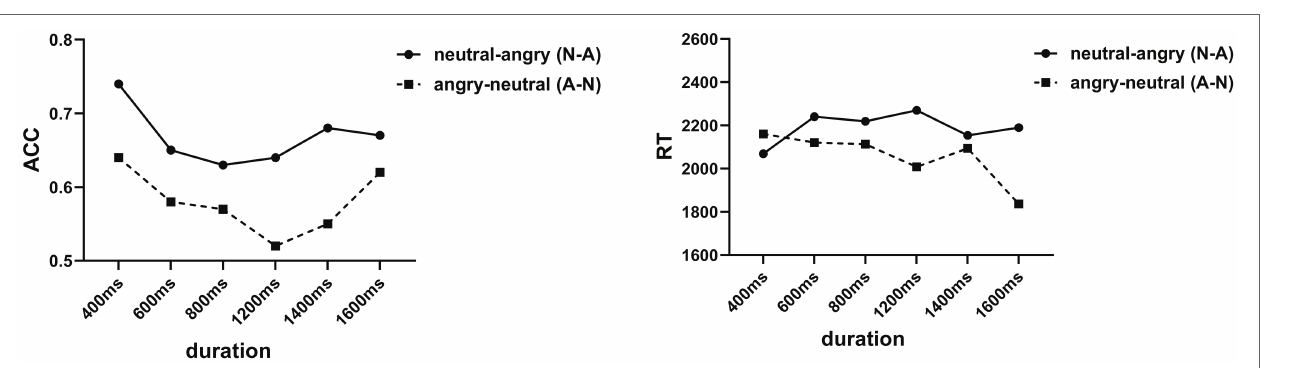
FIGURE 5 | ACC and RT under different durations and emotional localization.